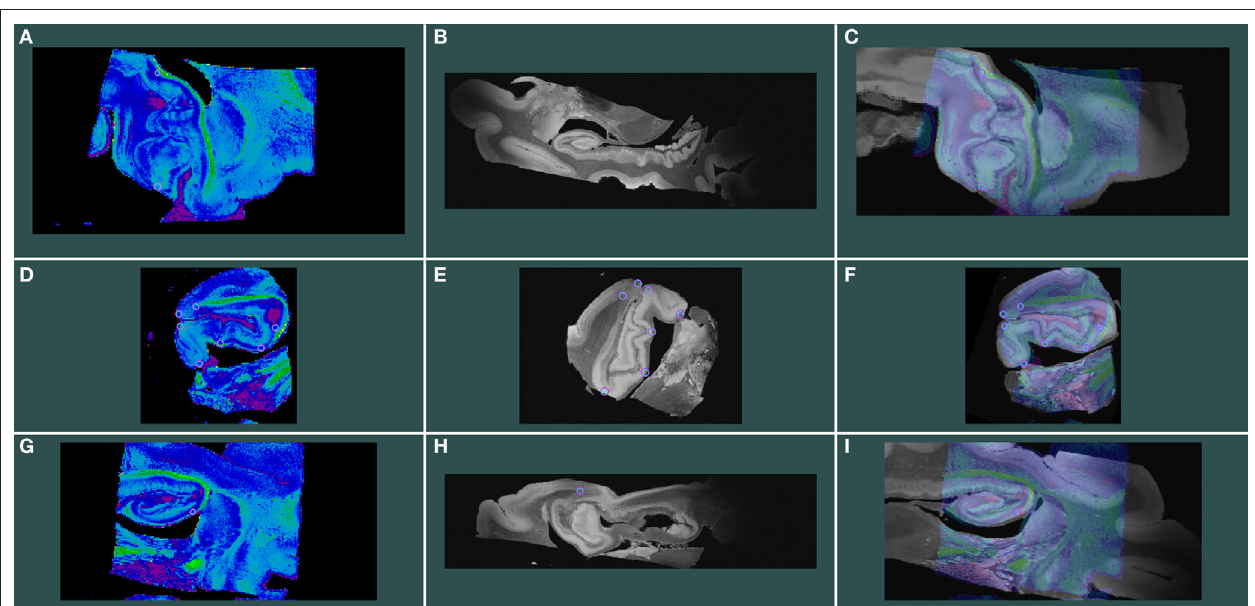
Figure 6 | isotropic 100 μm FLASH image registered with 200 μm isotropic DTi images. FA_DTI volume is shown in spectrum colors (A, D, and g) and structural MRI volume in grayscale (B, e, and H) and aligned volumes are shown as merged images (C, F, and i) . Rows represent planes of cut; top row shows horizontal, middle row represents coronal and bottom panel illustrates